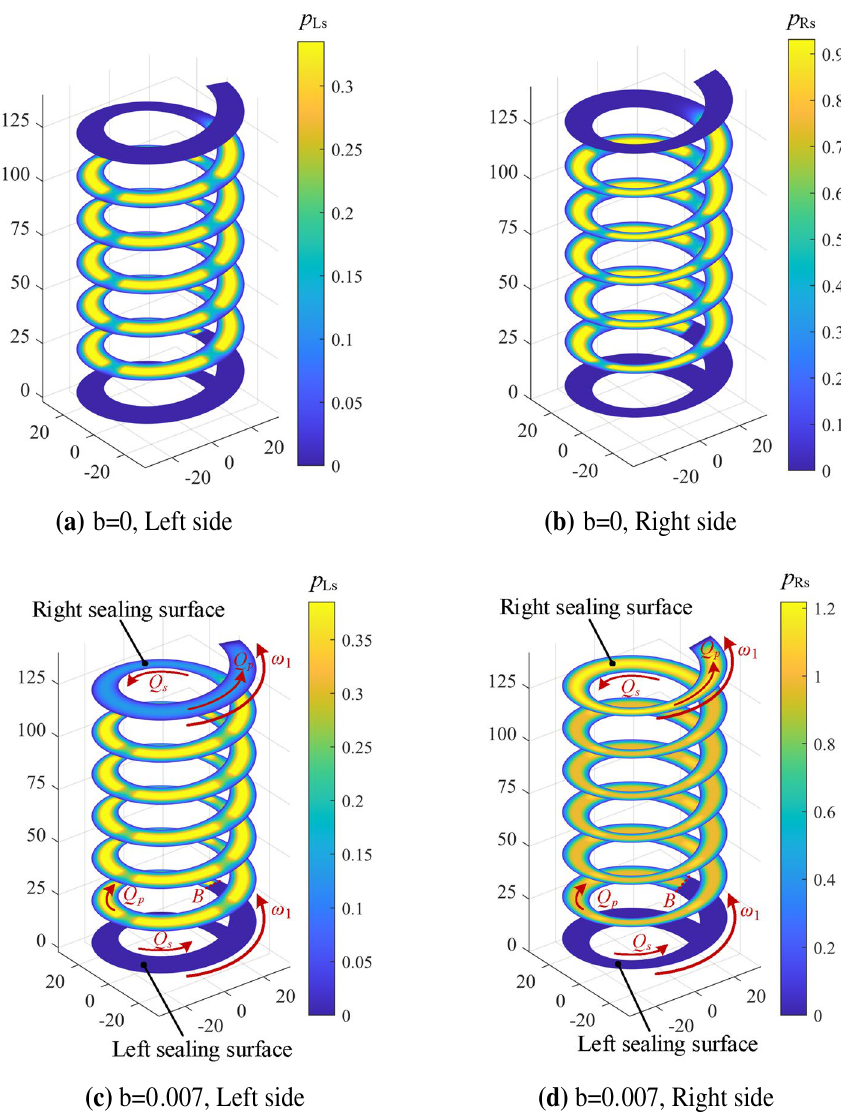
Figure 11. Steady-state pressure distribution under boundary slip condition with ω 1 = 9000 rpm, ω 2 = 0 rpm, Δ h = 0.5 h 0